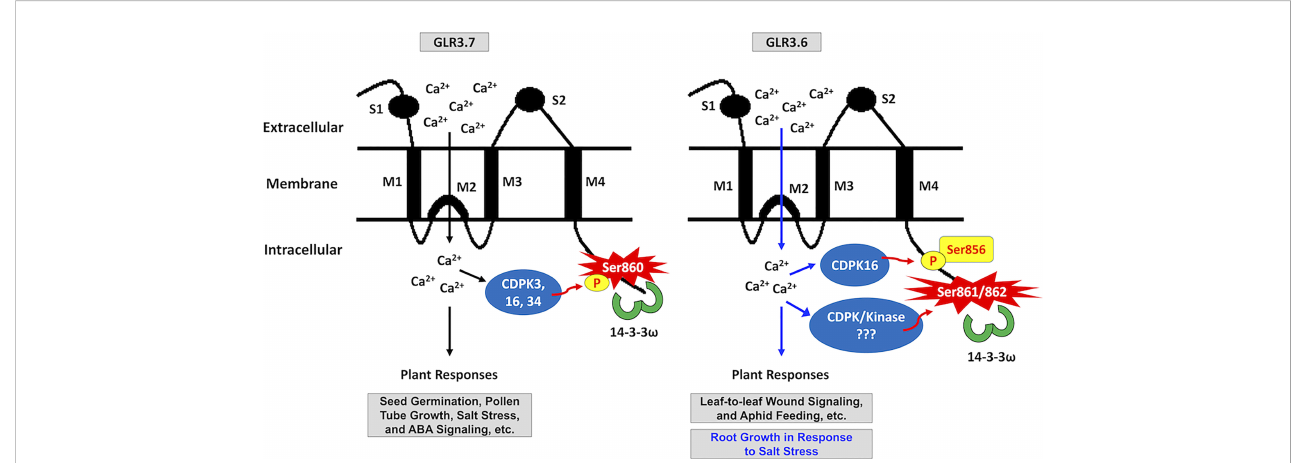
FIGURE 10 Schematic model of the 14-3-3 w binding site in clade-III GLR family members GLR3.6 and GLR3.7. S860 of GLR3.7 is phosphorylated by CDPK3, CDPK16, and CDPK34, which bind with 14-3-3 w to regulate ABA and salt response, seed germination, and root growth. This study postulated that S861/ 862 residues of GLR3.6 may be phosphorylated by uncharacterized CDPK and protein kinase, enabling the binding with the 14-3-3 w . Notably, the CDPK16 speci fi cally phosphorylates Ser856 residue of GLR3.6, but CDPK3 and CDPK34 do not. Additionally, Ser856 participates in salt stress-responsive primary root